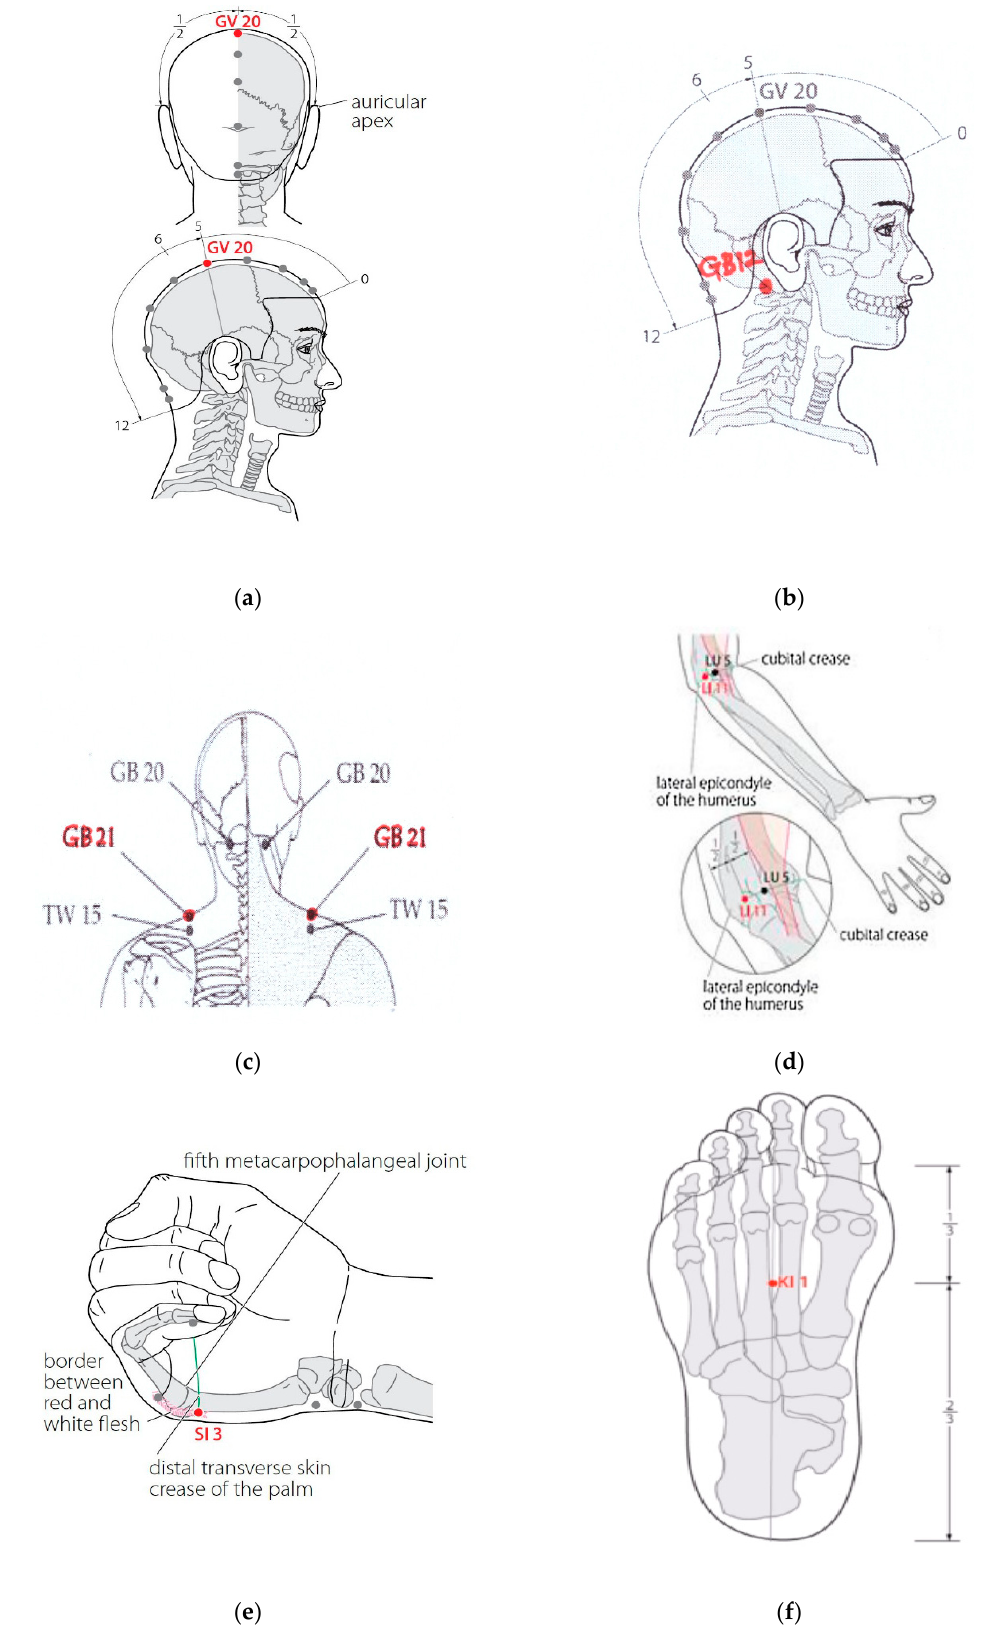
Figure 2. Meridian acupressure points. ( a ) GV 20 (BAIHUI); ( b ) GB 12 (WANGU); ( c ) GB 21 (JIANJING); ( d ) LI 11 (QUCHI); ( e ) SI 3 (HOUXI); ( f ) KI 1